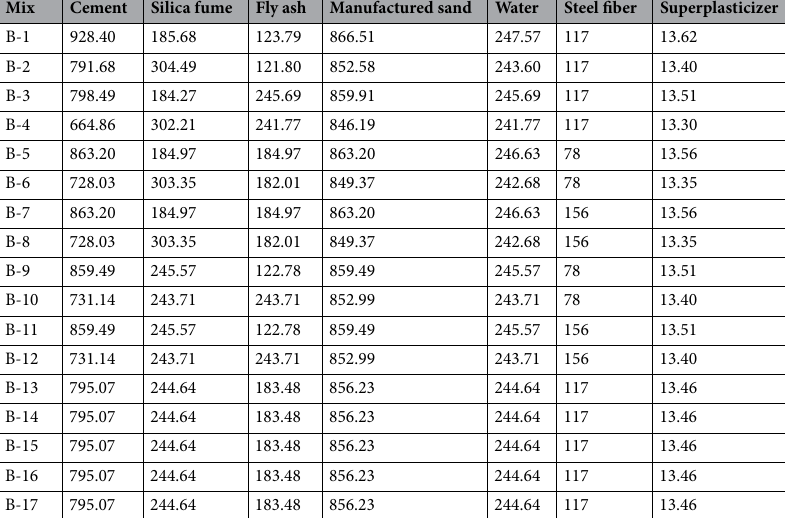
Table 2. The mix proportions of sprayed reactive powder concrete (kg/m 3 ).